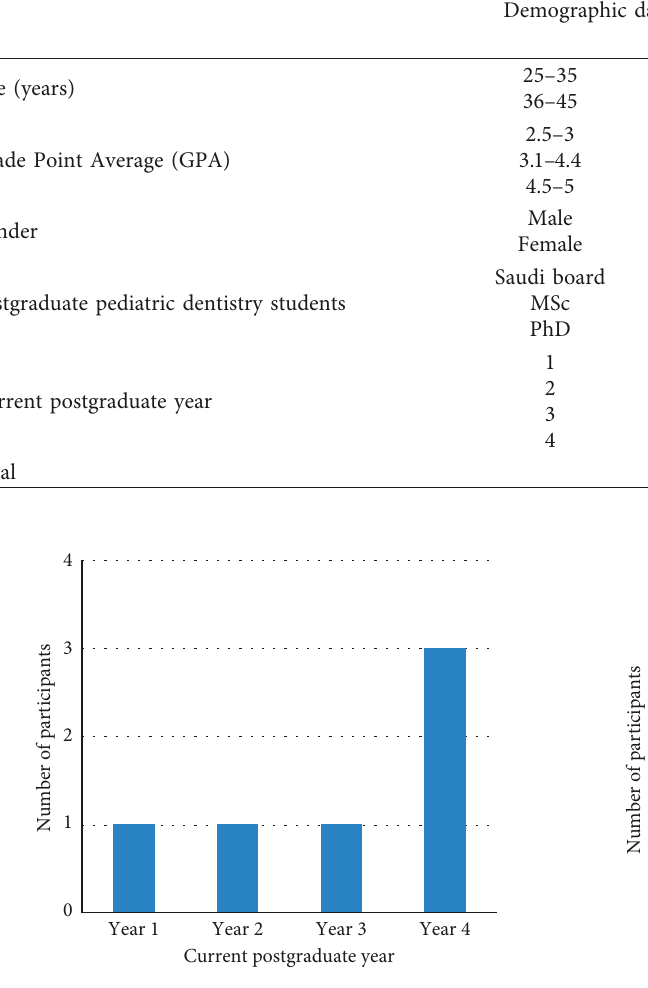
Figure 1: Level of anxiety during clinical investigations with re- spect to postgraduate current year.